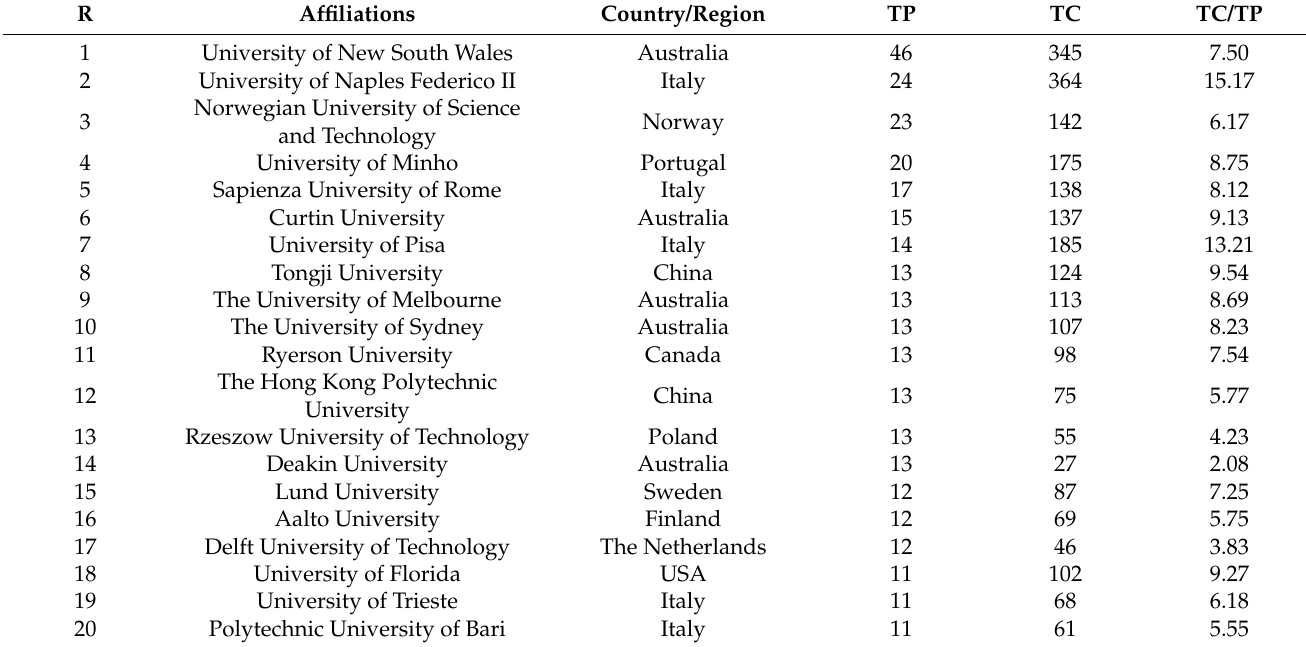
Table 5. Most productive affiliations.